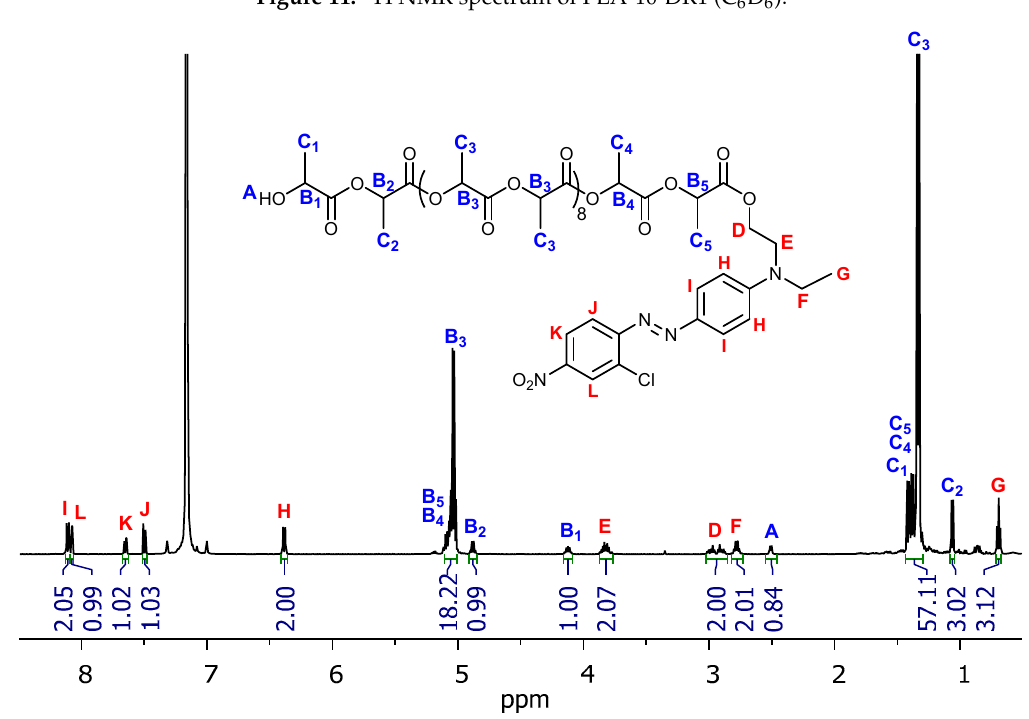
Figure 12. 1 H NMR spectrum of PLA-10-DR13 (C 6 D 6 ).